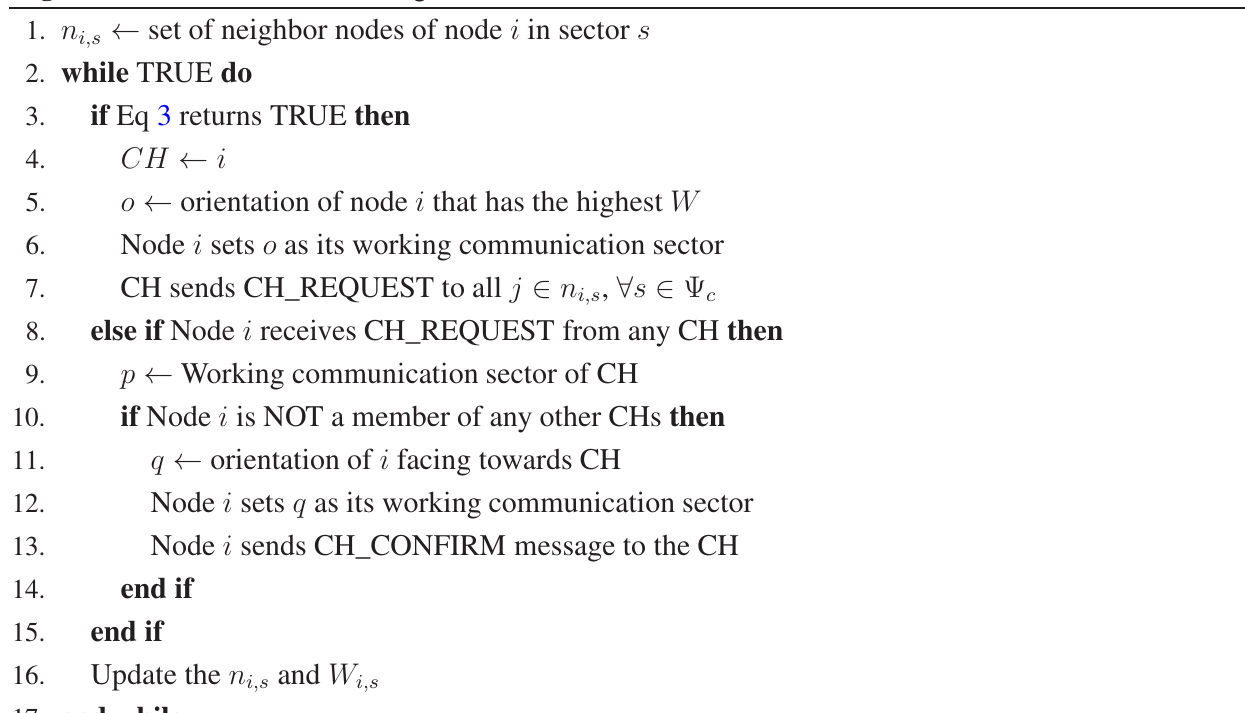
Algorithm 1 Cluster formation algorithm, at each sensor node i ∈ N .